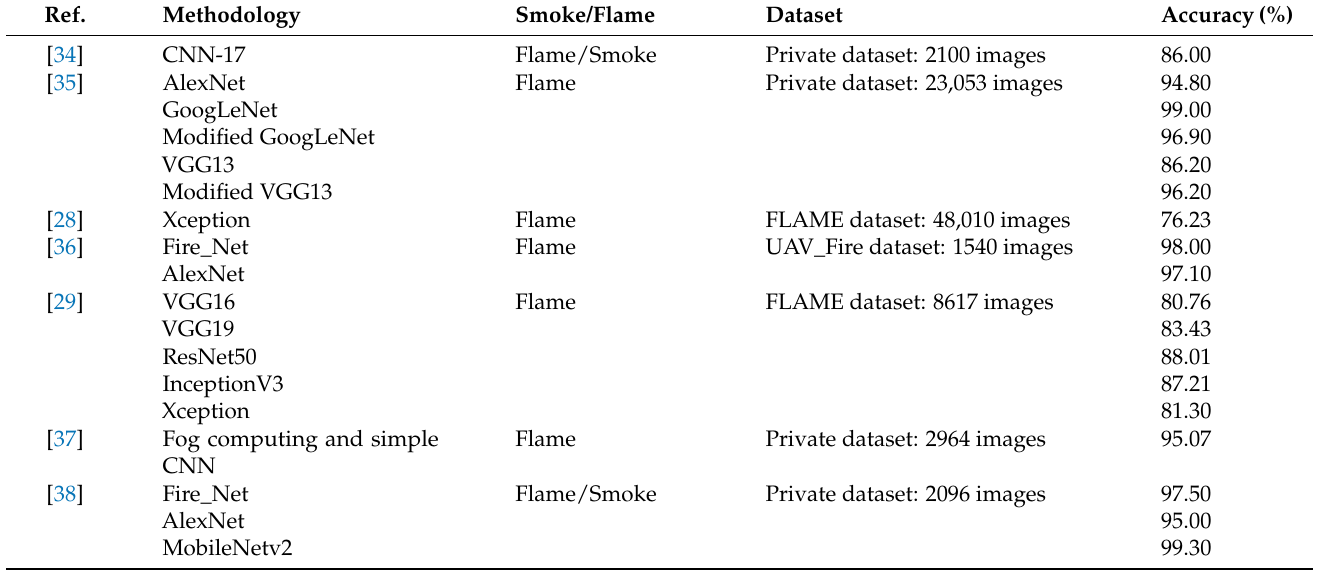
Table 1. Deep learning methods for UAV-based fire